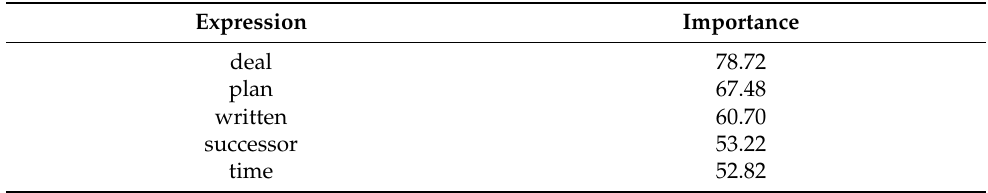
Table 3. Weight of criteria: starting the succession